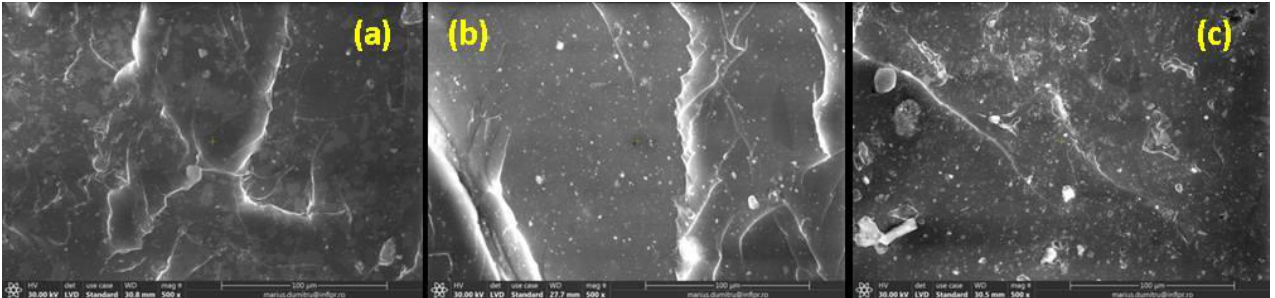
Figure 6. SEM micrographs at of non-irradiated control sample — natural rubber ( a ) and irradiated at 150 kGy ( b ) and 450 kGy ( c ) (magnification of 500).